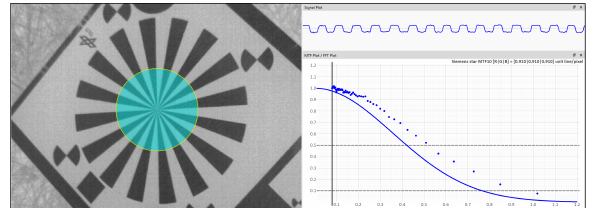
Figure 8. Siemens star pattern on a mirror imaged with LWIR camera module (left) and corresponding measurement